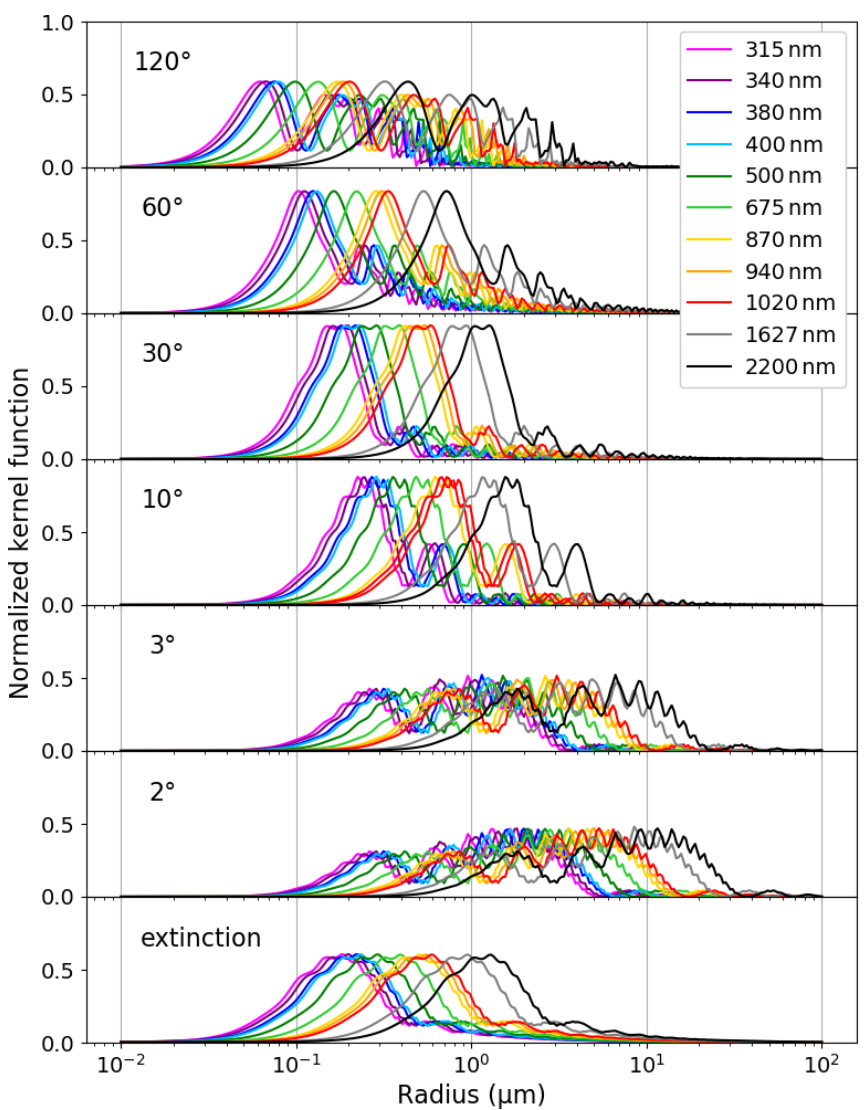
Figure B1. Normalized kernel functions for extinction and scattering at six scattering angles and at 11 wavelengths. The complex refractive index is assumed to be 1.45–3 . 5 × 10 − 3 i